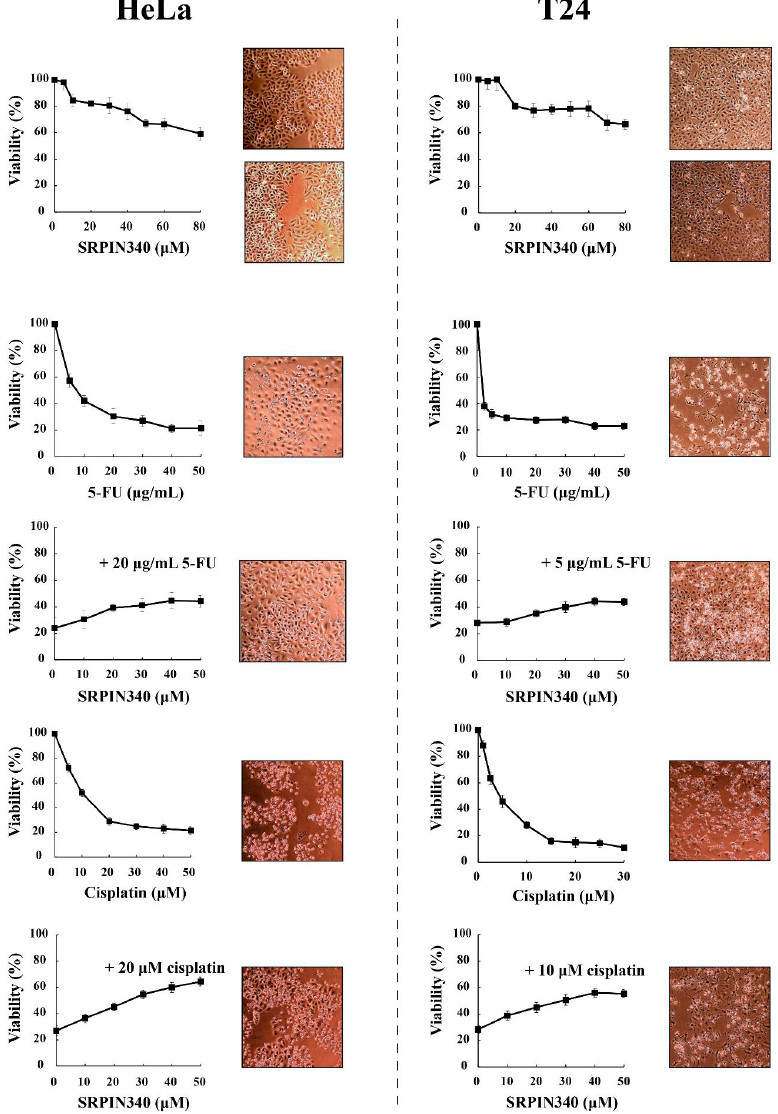
Figure 4. SRPIN340 protected HeLa and T24 cells from the cytotoxic effects of 5-FU and cisplatin. HeLa cells ( left panel ) were treated with SRPIN340 (5–80 µ M) for 48 h, 5-FU (5–50 µ g/mL) for 48 h, 5-FU (20 µ g/mL) plus SRPIN340 for 48 h, cisplatin (5–50 µ M) for 24 h, or cisplatin (20 µ M) plus SRPIN340 for 24 h. T24 cells ( right panel ) were treated with SRPIN340 (5–80 µ M) for 48 h, 5-FU (2.5–50 µ g/mL) for 48 h, 5-FU (5 µ g/mL) plus SRPIN340 for 48 h, cisplatin (1–30 µ M) for 48 h, or cisplatin (10 µ M) plus SRPIN340 for 48 h. The number of viable cells was measured using an MTT assay. Viability is expressed as a percentage of the viability of untreated cells, which was set to 100 percent. The density and morphology of control and treated cells were also observed using an inverted phase-contrast microscope at 10 × magnification. Images were captured at the same time points as the respective MTT